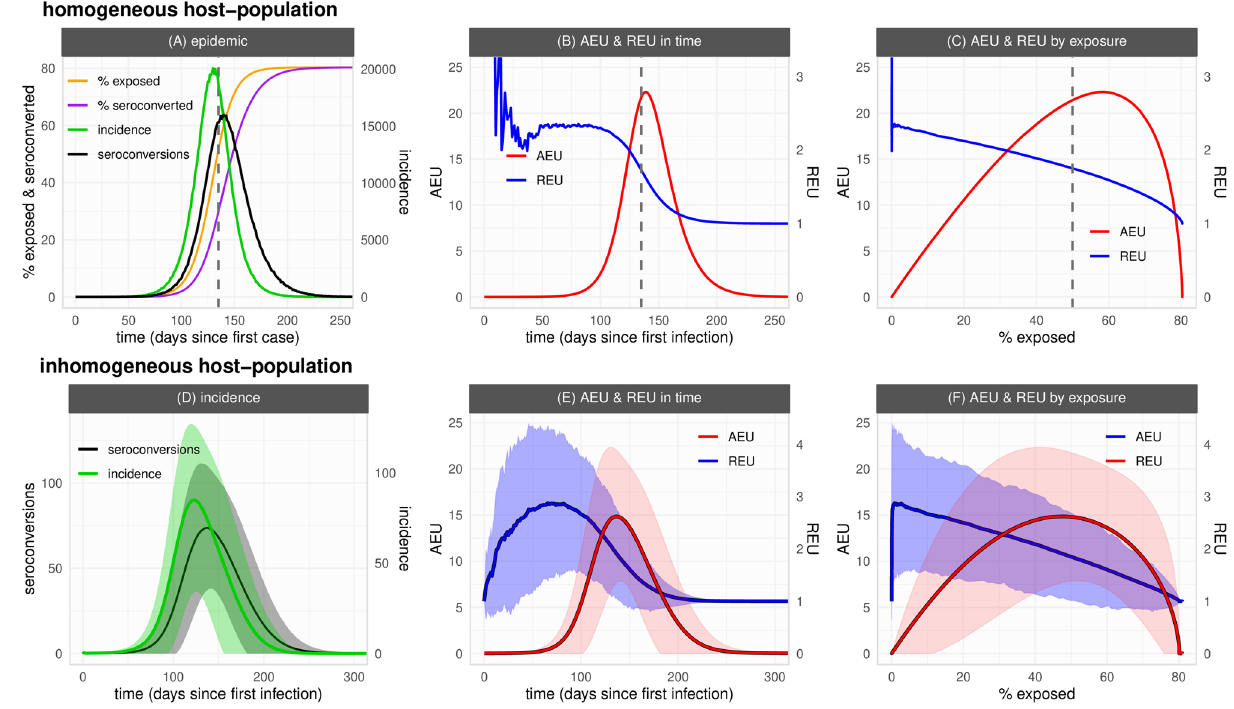
Figure 1. General seroepidemiological dynamics in both an homogeneous and inhomogeneous host- population. ( A ) Time series of cumulative incidence (exposed, orange), cumulative seroconverted (purple), incidence (green) and seroconversion (black) daily events. ( B , C ) Relative exposure underestimation (REU, blue) and absolute exposure underestimation (AEU, red) dependent on time ( B ) and the percent exposed ( C ). Outbreak simulated with parameters as default in Table 1. ( D ) Time series of incidence (green) and seroconversion (black) daily events. ( E , F ) REU (blue) and AEU (red) dependent on time ( E ) and the percent exposed (F). ( A – C ) Vertical dashed line marks the day in which the theoretical herd-immunity threshold is reached. Curves present the output of a single stochastic simulation. ( D – F ) Lines are the mean and areas the standard deviation of model output across all communities of the meta-population among 100 outbreaks 2 simulated with parameters as default in Table 1 except nC = 144 ( 12